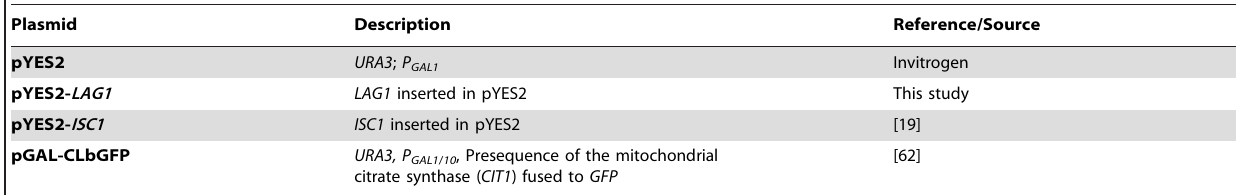
Table 3. List of plasmids used in this study.